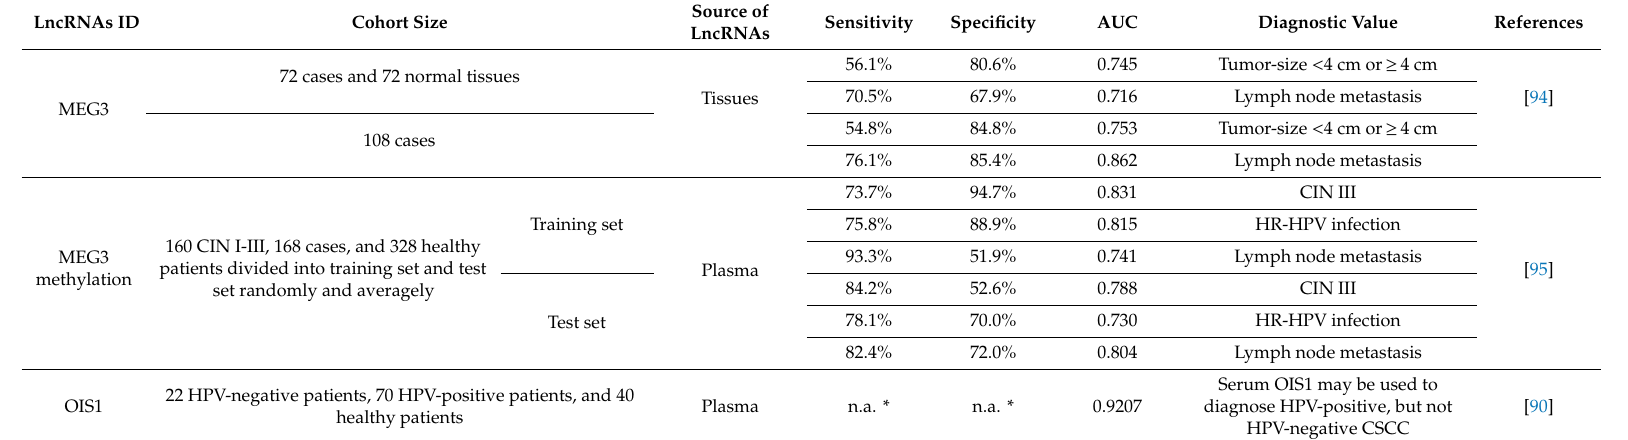
Table 4. Diagnostic value of long non-coding RNAs (lncRNAs) in cervical squamous cell